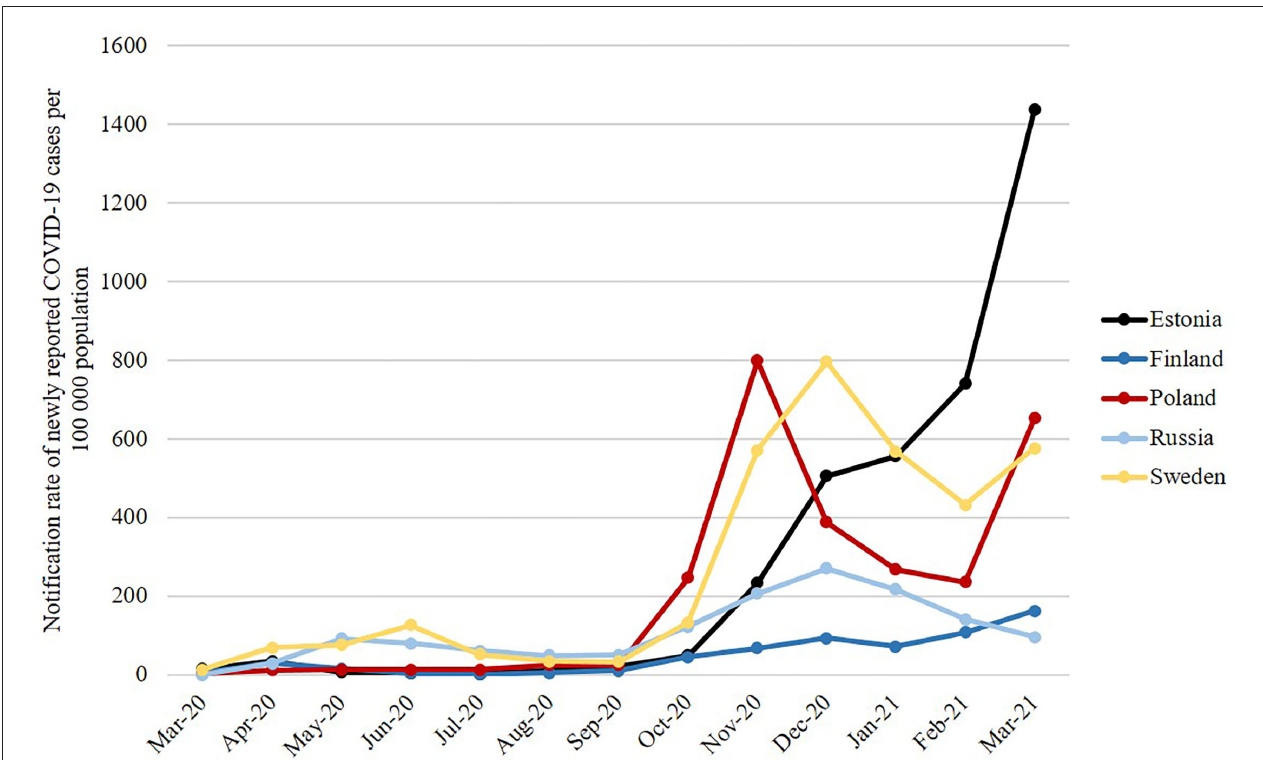
FIGURE 2 | Monthly averages of the 14-day notification rate of newly reported COVID-19 cases per 100 000 population between March 2020 and March 2021. Source: own calculation based on ECDC.